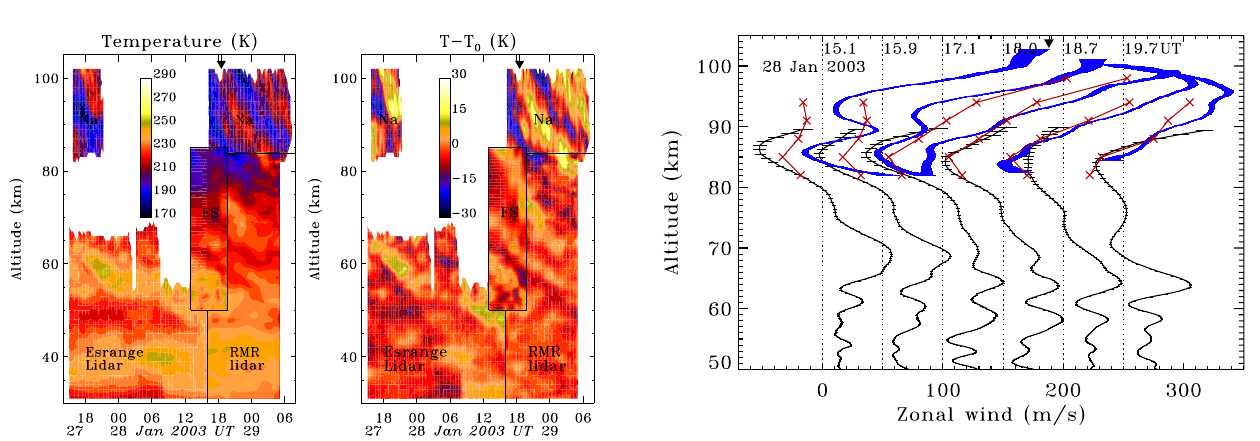
Fig. 15. A temperature (left) and temperature difference (right) map for 27–28 January 2003 as determined by combining RMR and Na lidar data at ARR with RMR lidar and FS data at Esrange. The blocks distinguish the regions where temperature is measured by each specified technique. In the right panel, T o indicates the mean temperature profile within the specified block. The small arrow at the top of each panel represents the launch of NASA 41.031 on 28 January 2003. The figure emphasizes the consistency between sites and large-scale of the planetary wave observed above 80km. The difference map also shows small-scale structure superimposed on the large wave.